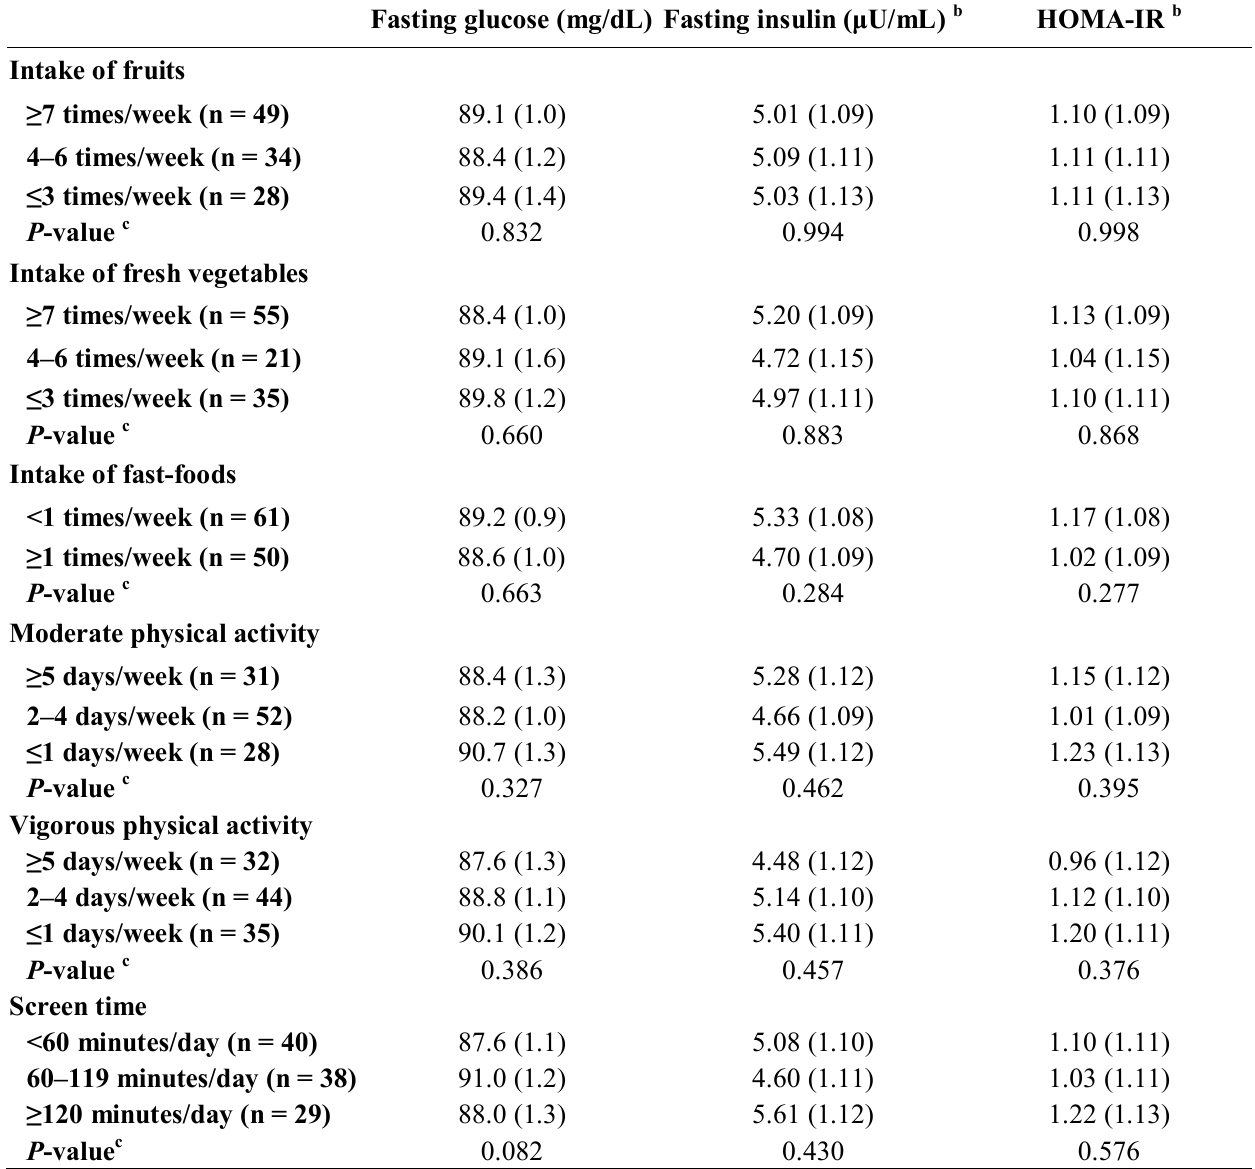
Table 4. Sex-adjusted mean levels of fasting glucose, fasting insulin, and HOMA-IR according to lifestyle habits.